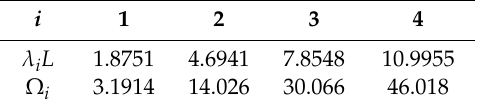
Table 1. λ i L and Ω i for non-shear boring bar and shear boring bar, respectively.